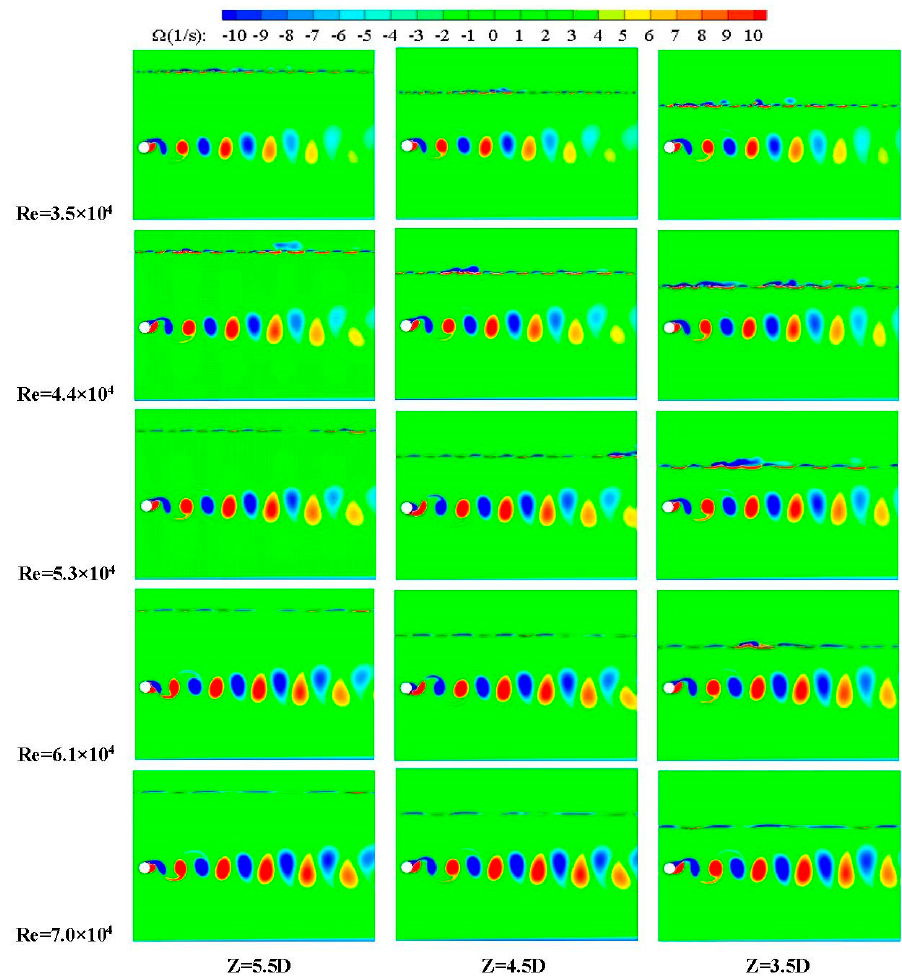
Figure 12. The vortex structure of the stationary PTC cylinder in the free surface flow. (b) Flow-Induced